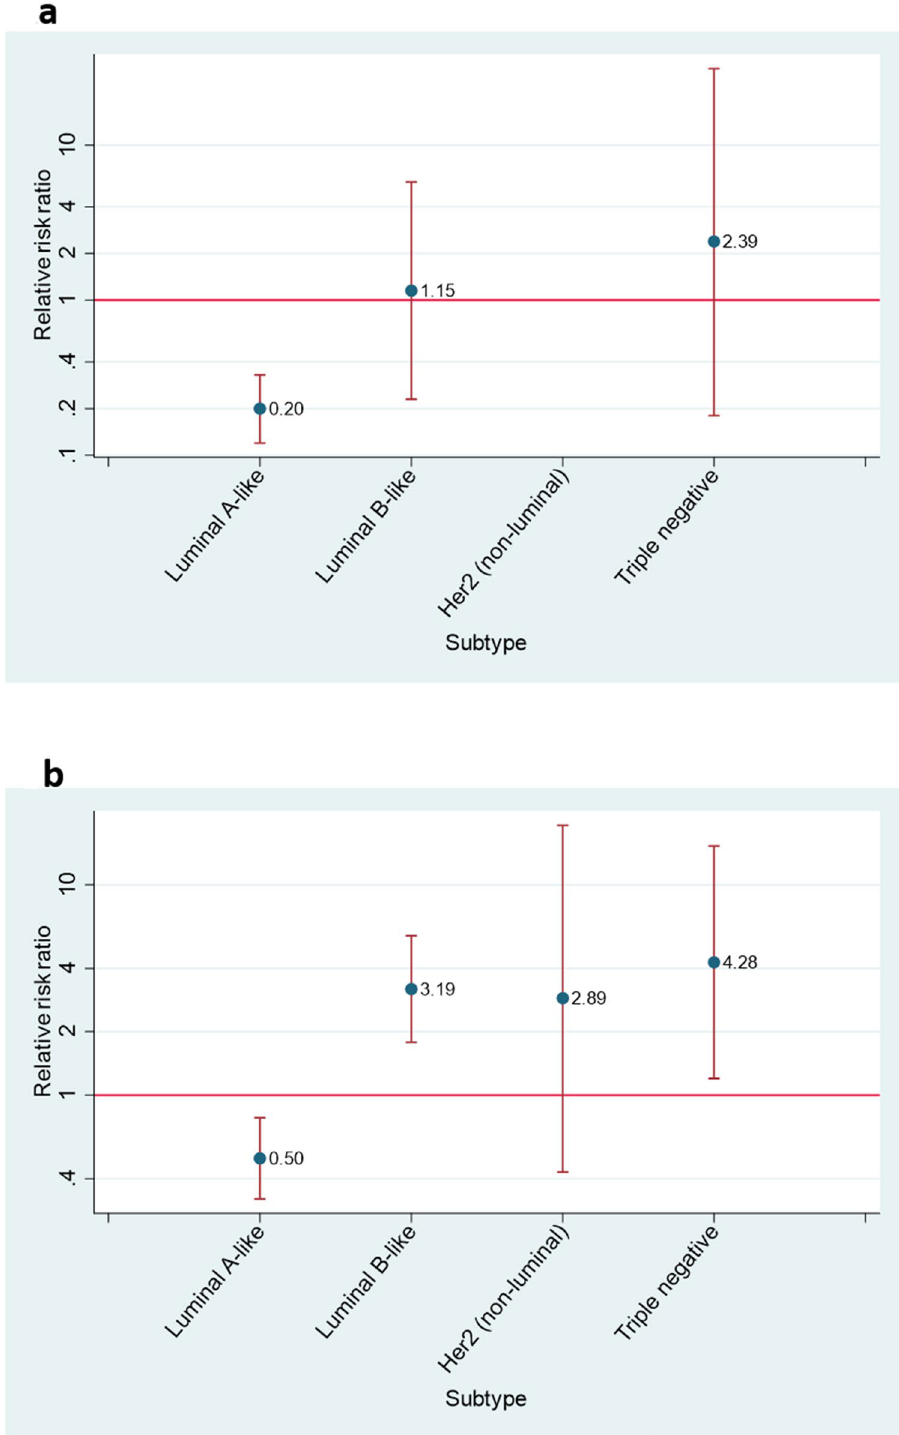
Figure 2. Relative risk ratios (RRR) for women over 65 years old compared with women under 65 years old of being treated Over ( a ) or Under ( b ) St Gallen. In ( a ), RRR > 1 indicates that women over 65 were more likely to be treated Over St Gallen than women under 65 years old, while in ( b ), RRR > 1 indicates that women over 65 were more likely to be treated Under St Gallen than women under 65. Results on HER2 + tumours treated Over St Gallen are not shown as analysis did not